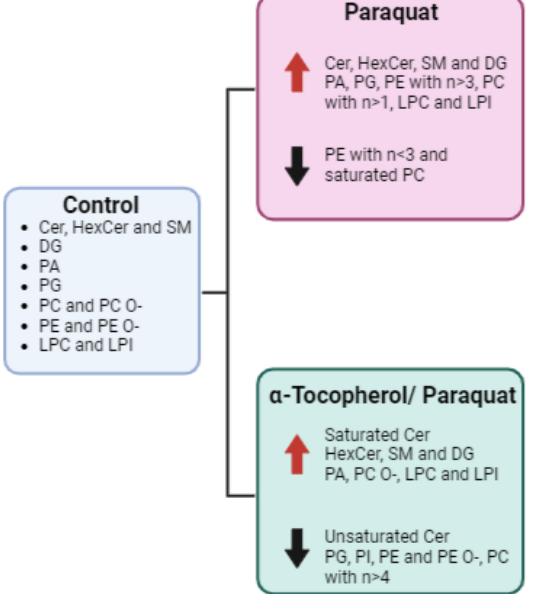
Figure 4. Graphic summary of lipid changes observed in CMMAs upon oxidative stress preceded or not by antioxidant treatment.